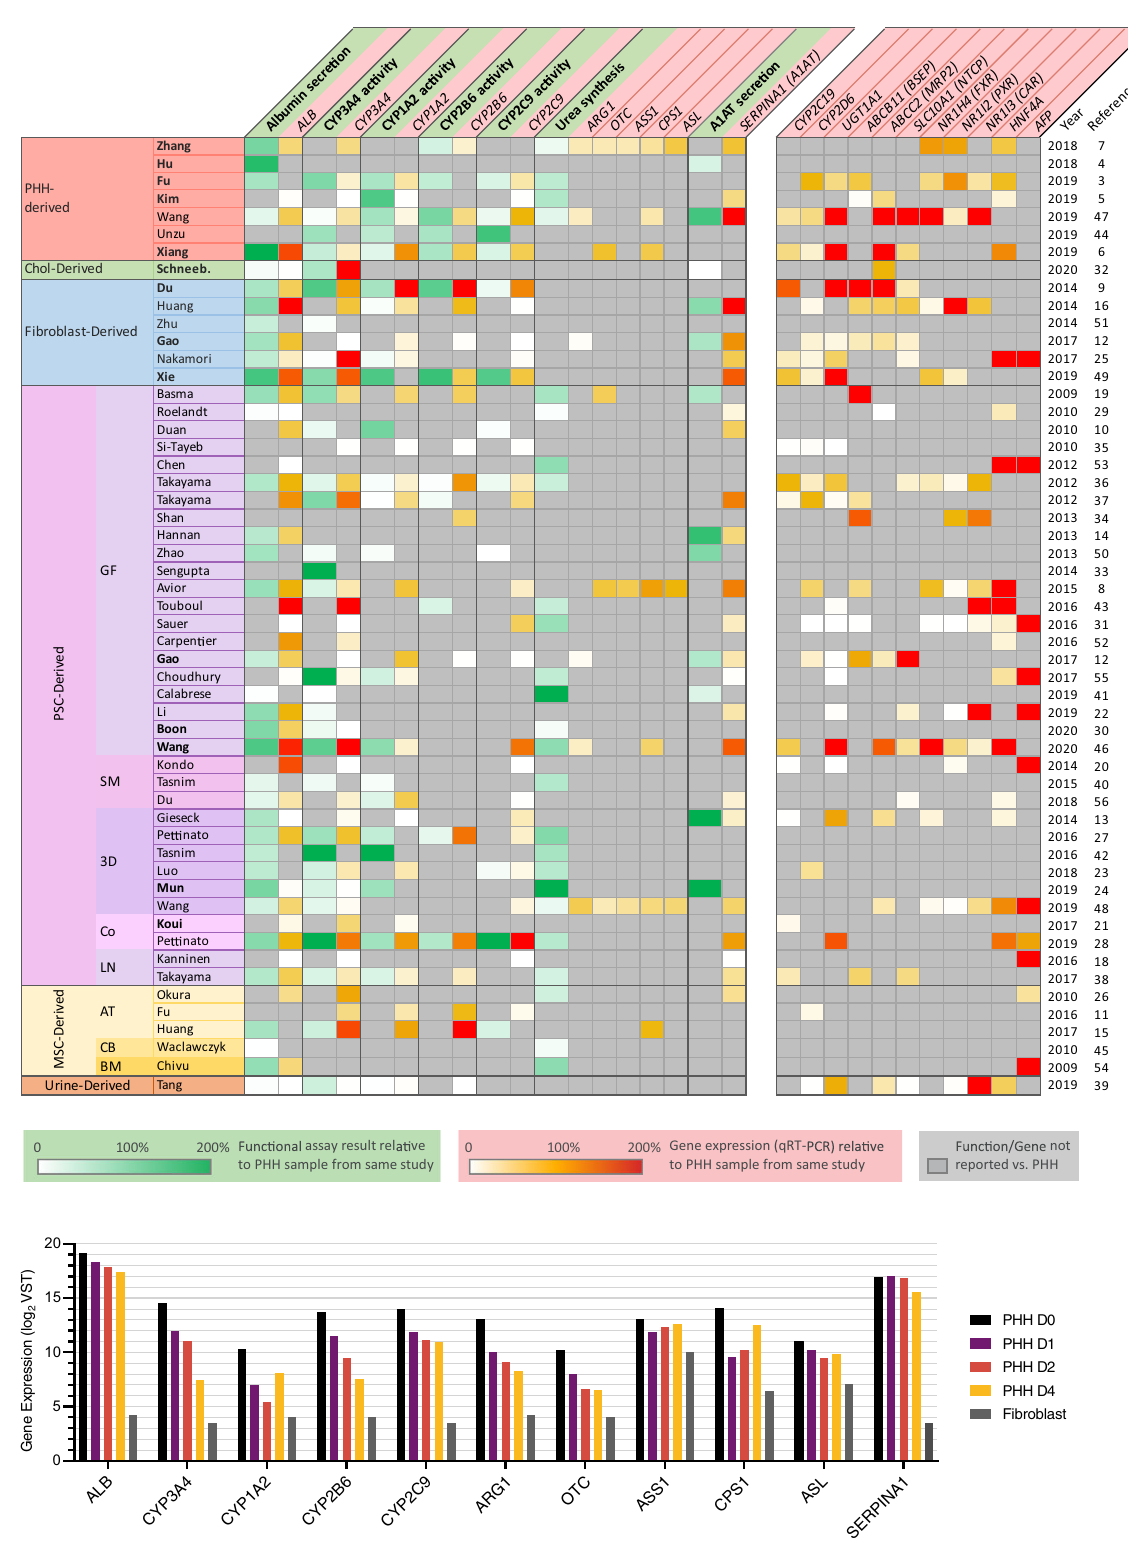
to PHH sample from samestudy